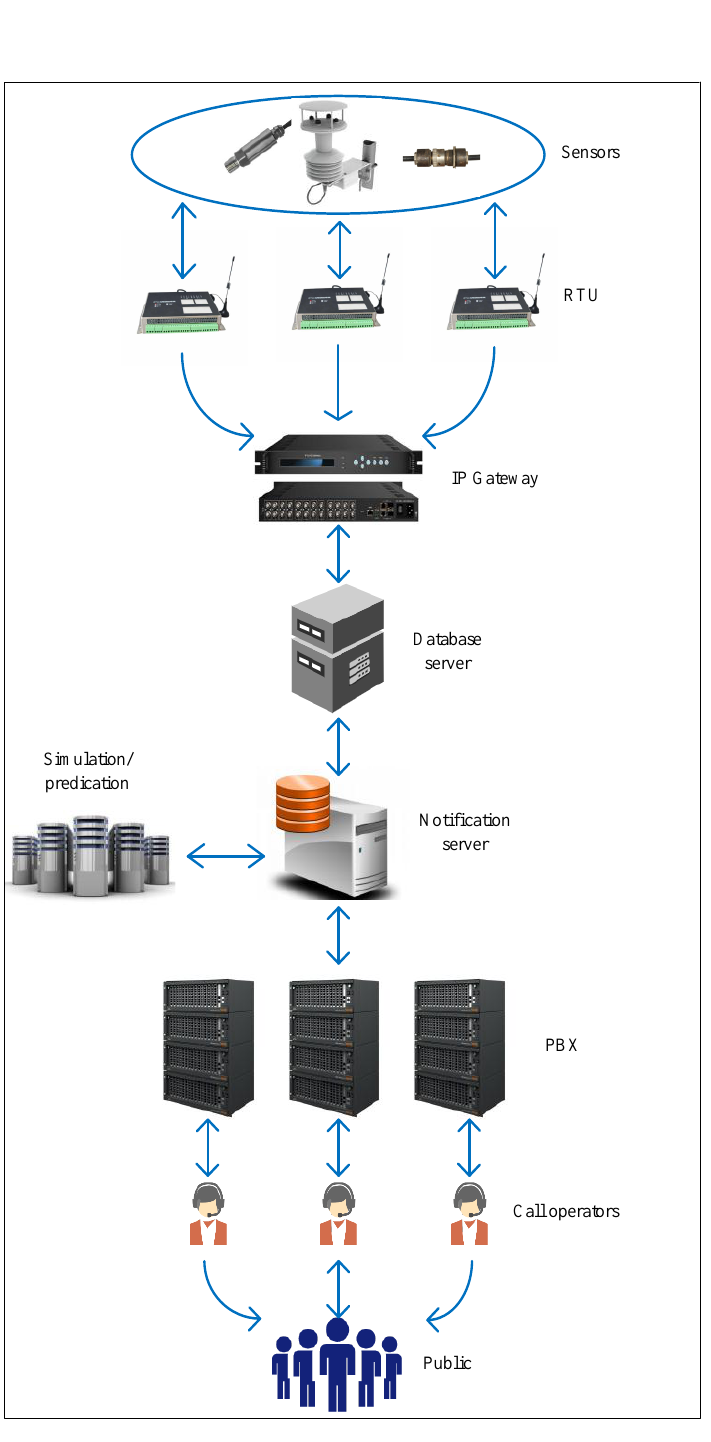
Figure 5. The activities of disaster early warning using Time-Critical IoT on Elastic Cloud